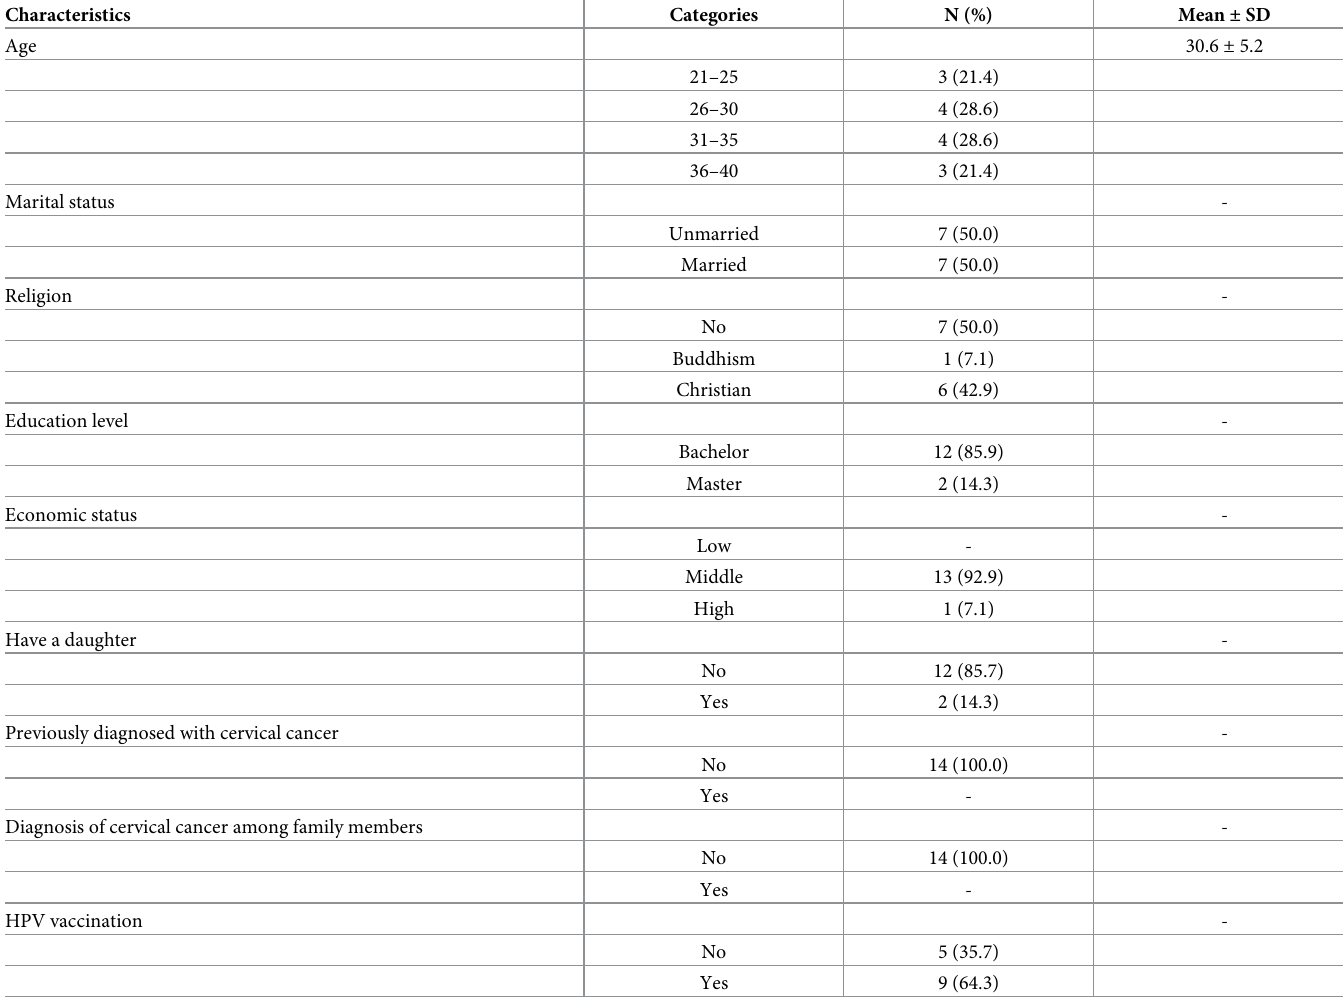
Table 1. Characteristics of the subjects (N =